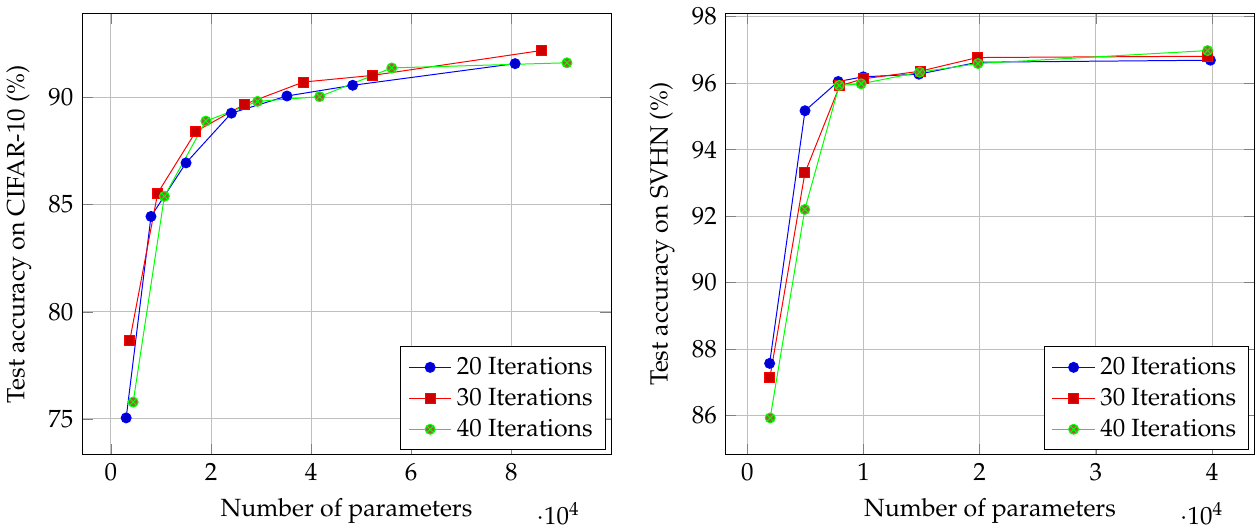
Figure 5. Accuracy on CIFAR-10 ( left ) and SVHN ( right ) as function of the number of parameters. Experiments were performed for different numbers of iterations (T) of an augmented ThriftyNet. h =5. Pooling was performed every T/5 iterations. The number of filters varied from 32 to 256 by increments of